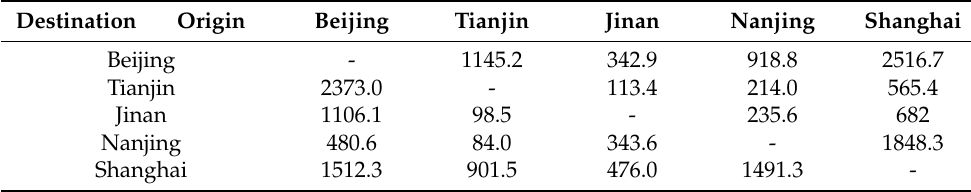
Table 2. Daily demand for inter-city express travel in 2022